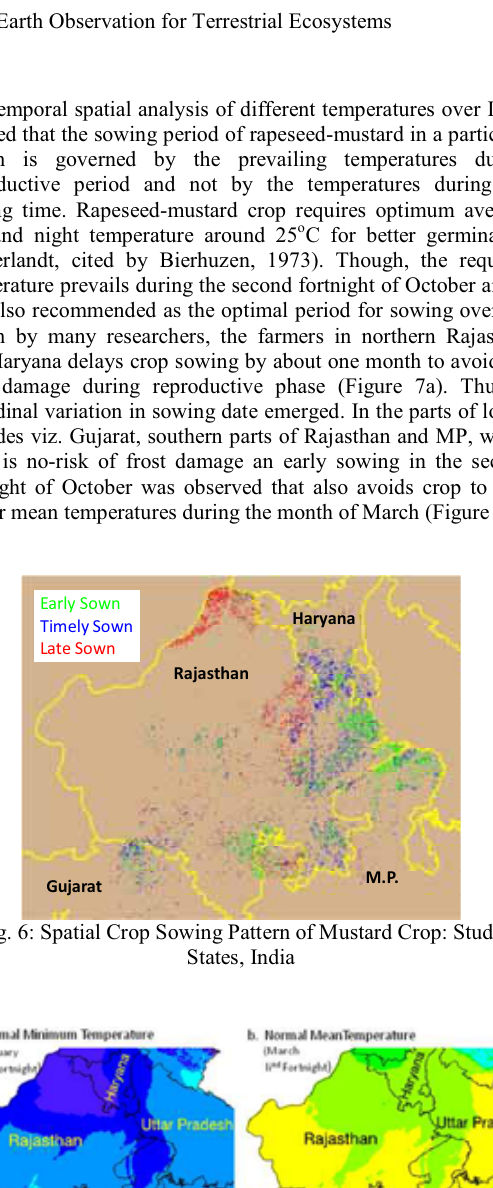
Fig. 4: Three of Reference Temporal Spectral Profiles